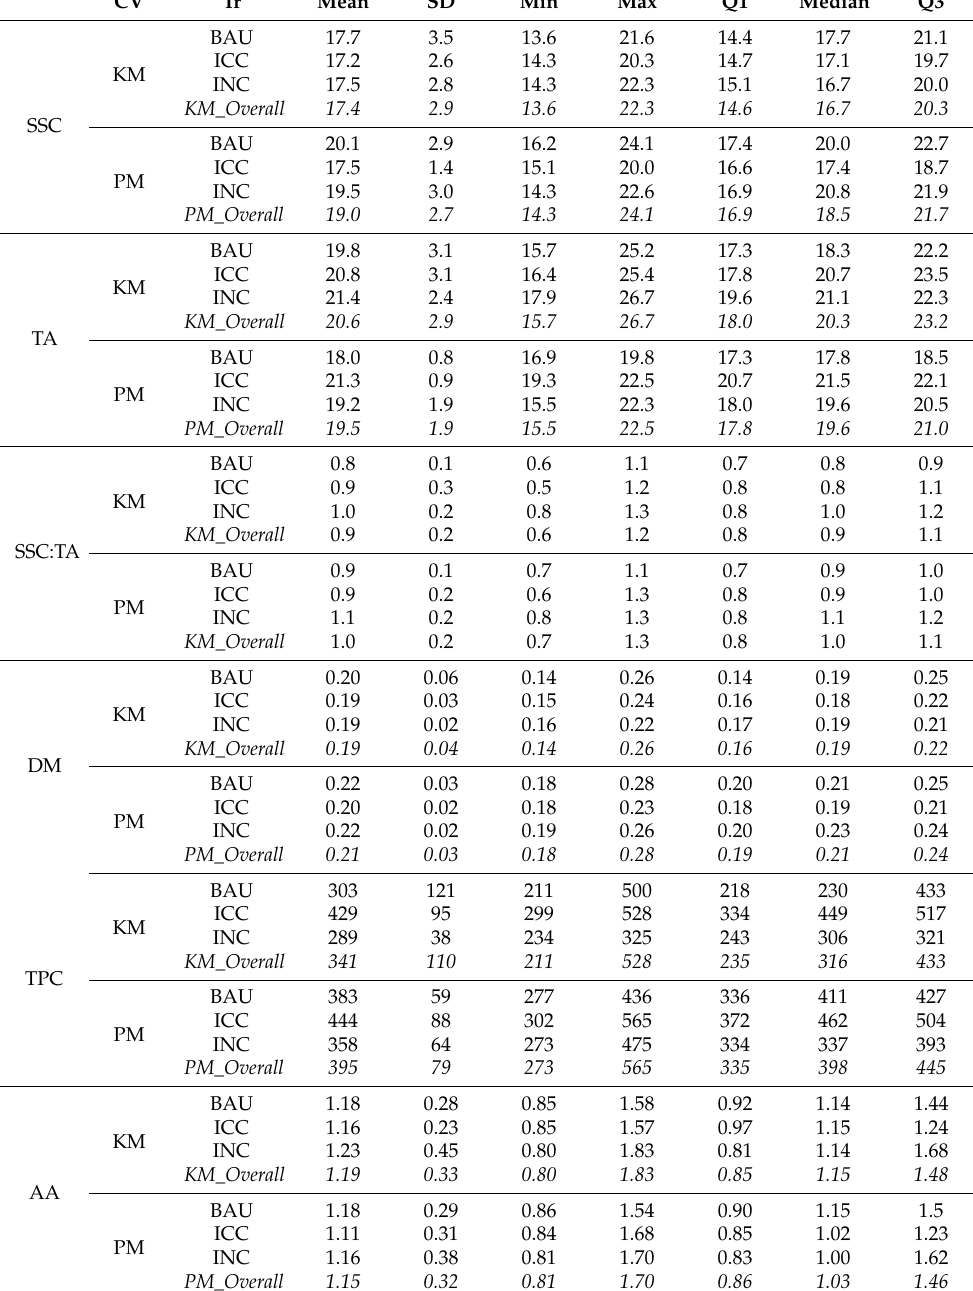
Table 3. Descriptive statistics, including mean, standard deviation (SD), minimum (Min) and maxi- mum (Max) values, 25th percentile (Q1), median, and 75th percentile (Q3), for quality parameters, as a function of cultivar (Kioto* KM and Pieve* PM) and agronomic treatment (Business As Usual—BAU; Innovative diversified system with Natural cover and Compost use—ICC; Innovative diversified system with introduced Cover and Compost